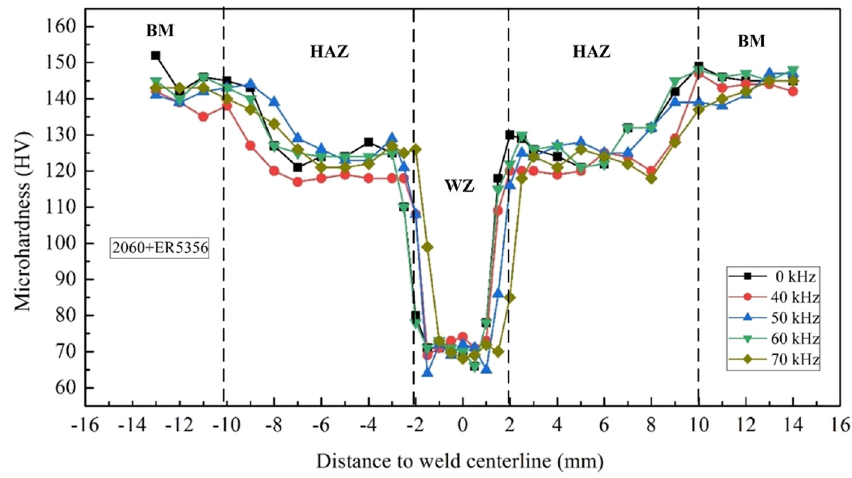
Figure 11: Hardness distribution on the weld joints with